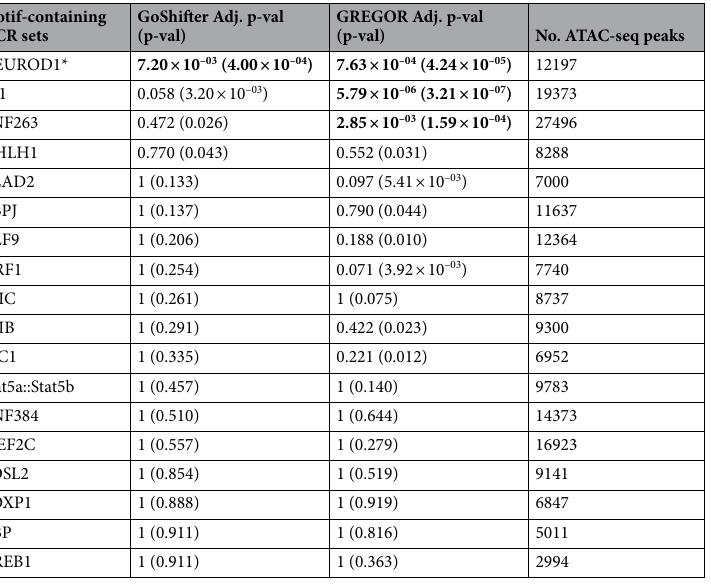
Table 3. Enrichment of PD risk variants within open chromatin region sets containing known motifs identified with MEME-ChIP. The motif-containing OCR set passing the significance threshold with both GoShifter and GREGOR is marked with a star and is reported in the text as significantly enriched with PD risk variants. We adjusted for multiple testing by Bonferroni correction, adjusting for 18 tests. Unadjusted p-values are provided in parenthesis. Adjusted p-val < 0.05 are written in bold. No. ATAC-seq peaks refers to the total number of peaks, representing OCRs, in the analysed motif-containing open chromatin sets. The total number of ATAC-seq peaks in superior temporal cortex neurons is 76145. PD, Parkinson’s disease; OCR, Open chromatin